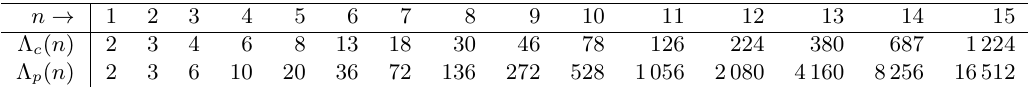
The number, Λ , of automorphism classes of game states if the underlying graph c ( n ) is a cycle of order n , for small values of n (Sloane’s sequence A000029 [11]). The corresponding number, Λ , of automorphism classes of game states, taken from [1, Table 3.2], for the ESPD p ( n ) on a path of order n is also shown for purposes of comparison.